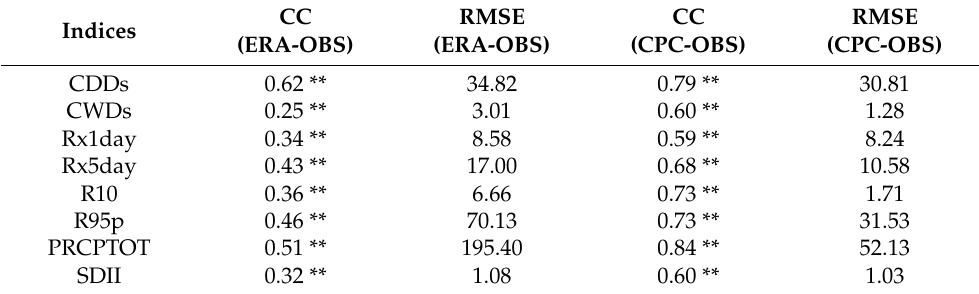
Table 3. CC and RMSE of eight regional mean annual precipitation series obtained from ERA/CPC and OBS in CA during